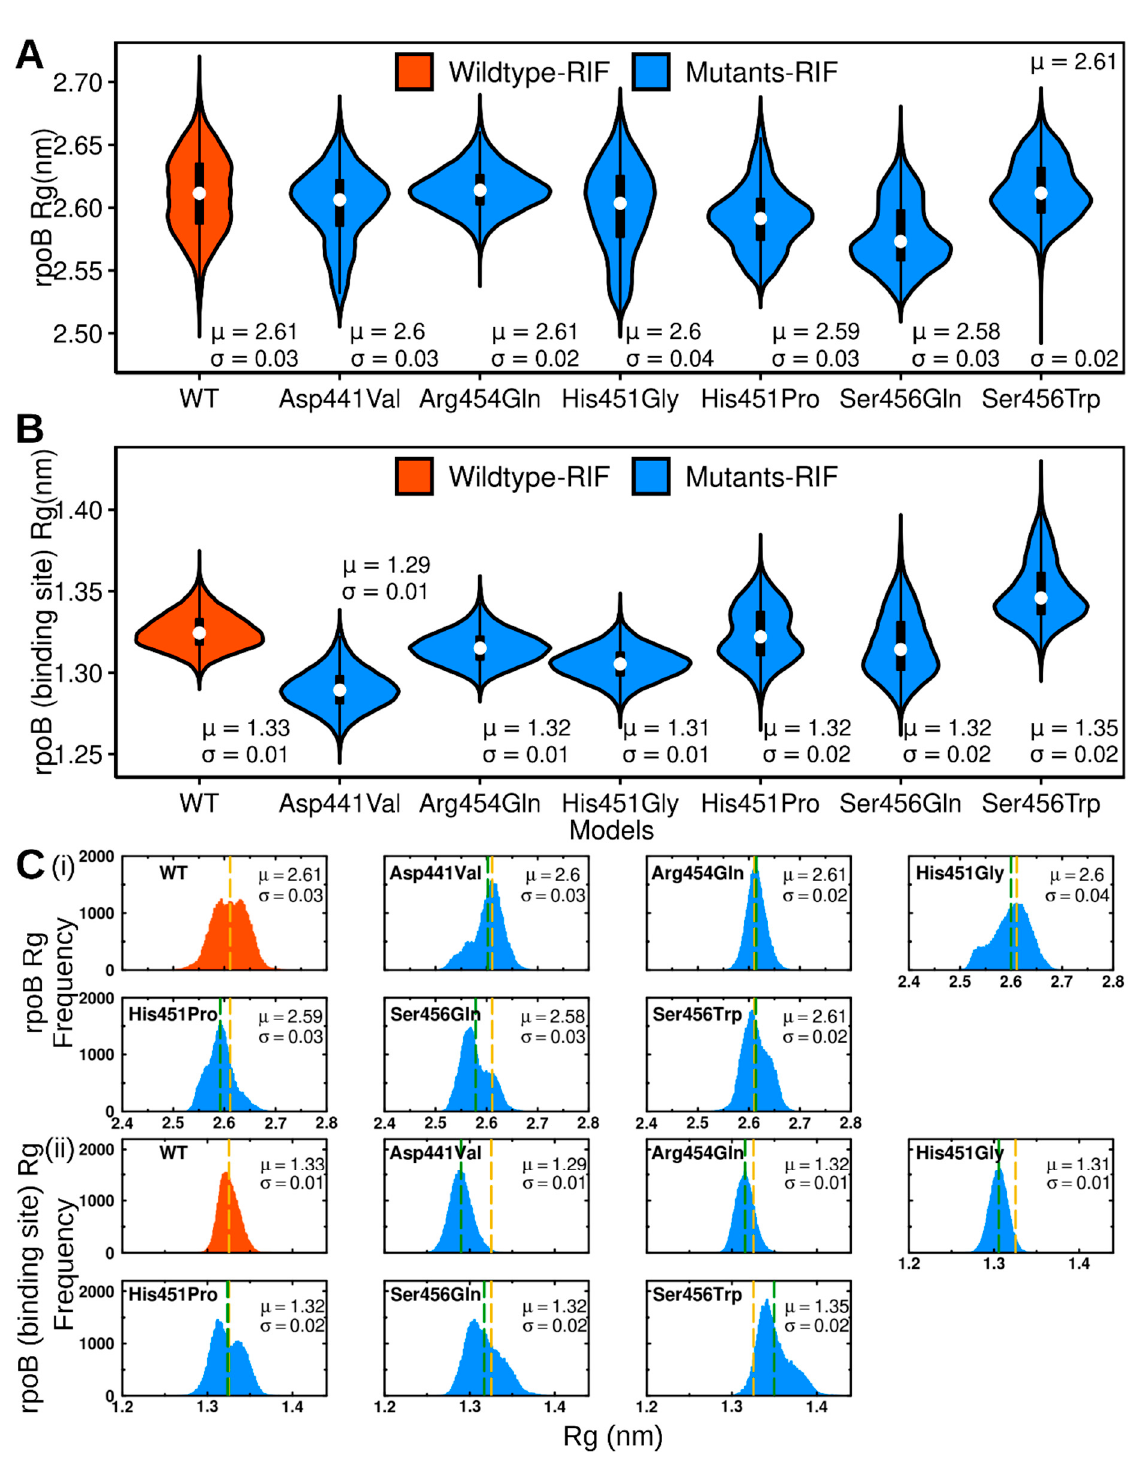
Figure 4. Violin plots illustrating the kernel density distribution frequency of the radius of gyration for ( A ): The entire protein structure, ( B ): residues within the RIF binding site. Color key: red: bound WT, blue: bound mutants. The boxplots within highlight the data distribution (25th (bottom) and 75th (top) percentiles). The white dot indicates the median value. ( C ) Histogram representation of Rg distribution for ( i ) the entire protein and ( ii ) RIF binding site. Color key: red: bound WT, blue: bound mutants. Dashed lines represent the mean Rg value: yellow: bound WT, green: bound mutants.